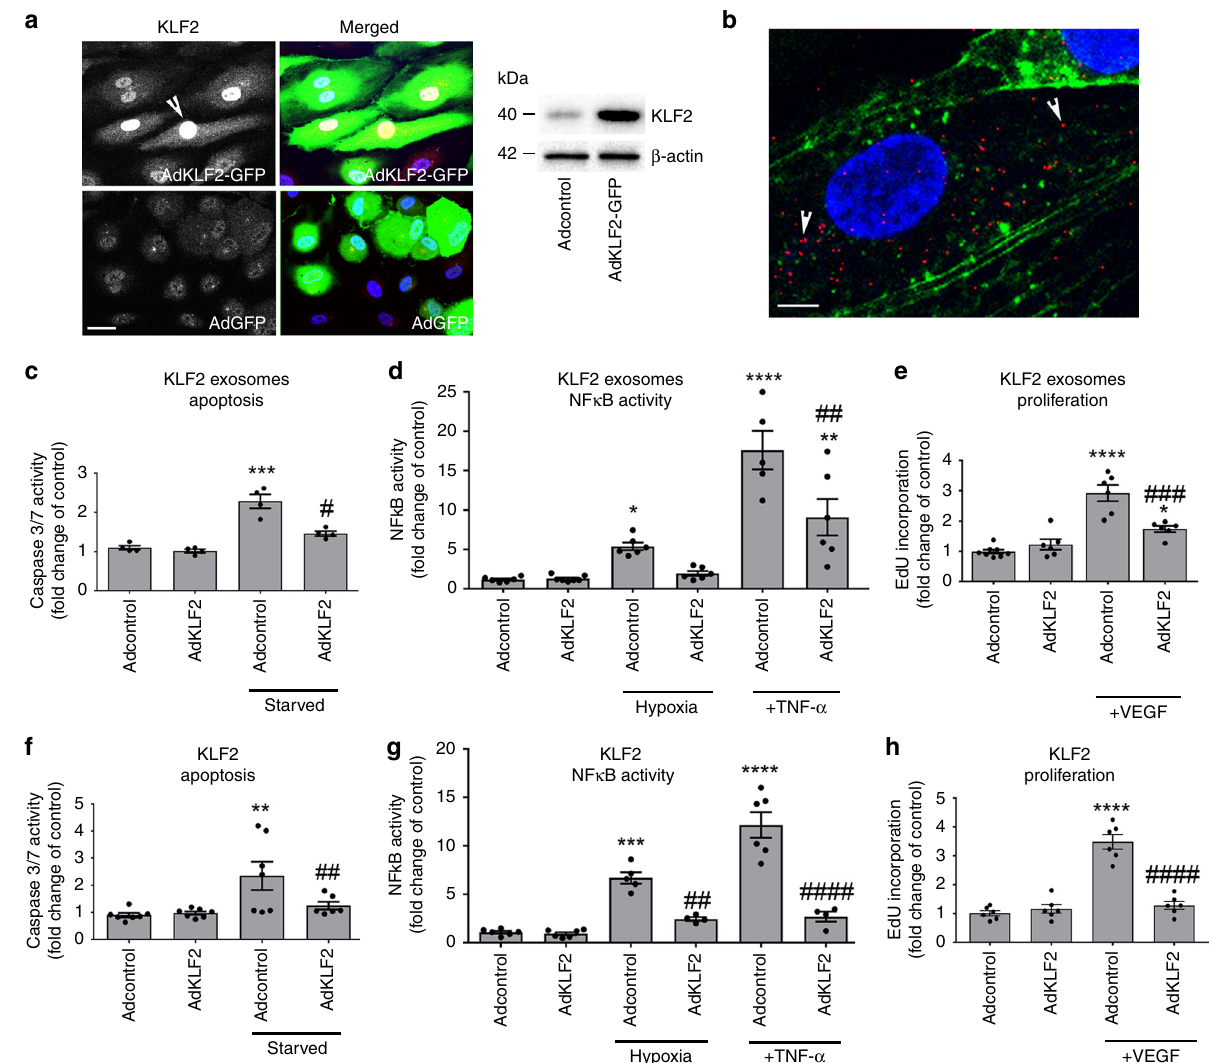
Fig. 1 Effect of KLF2 and KLF2-induced exosomes on endothelial cell apoptosis, in fl ammatory activation and proliferation. a Expression of KLF2 in cells infected with AdGFP and AdKLF2-GFP (24 h). Infected cells are green and the arrowhead points to nuclear localisation of KLF2; bar = 10 µ m. b Internalisation of PKH26 Red-labelled exosomes (arrowheads) 1 h after treatment. Bar = 2 µ m. Effects of c – e KLF2-induced exosomes and KLF2 ( f – h ) on caspase 3 per 7 activation in serum-starved HPAECs (24 h), hypoxia- and TNF- α -induced (10 µ g/L, 24 h) NF κ B activation and VEGF-induced (50 ng/mL, 18 h) cell proliferation in HPAECs, as indicated. Control exosomes were puri fi ed from AdGFP-expressing cells, while KLF2 exosomes were puri fi ed from AdKLF2-overexpressing HPAECs. ** P < 0.01; *** P < 0.001, **** P < 0.0001 comparison with Adcontrol. # P < 0.05, ## P < 0.01, #### P < 0.0001